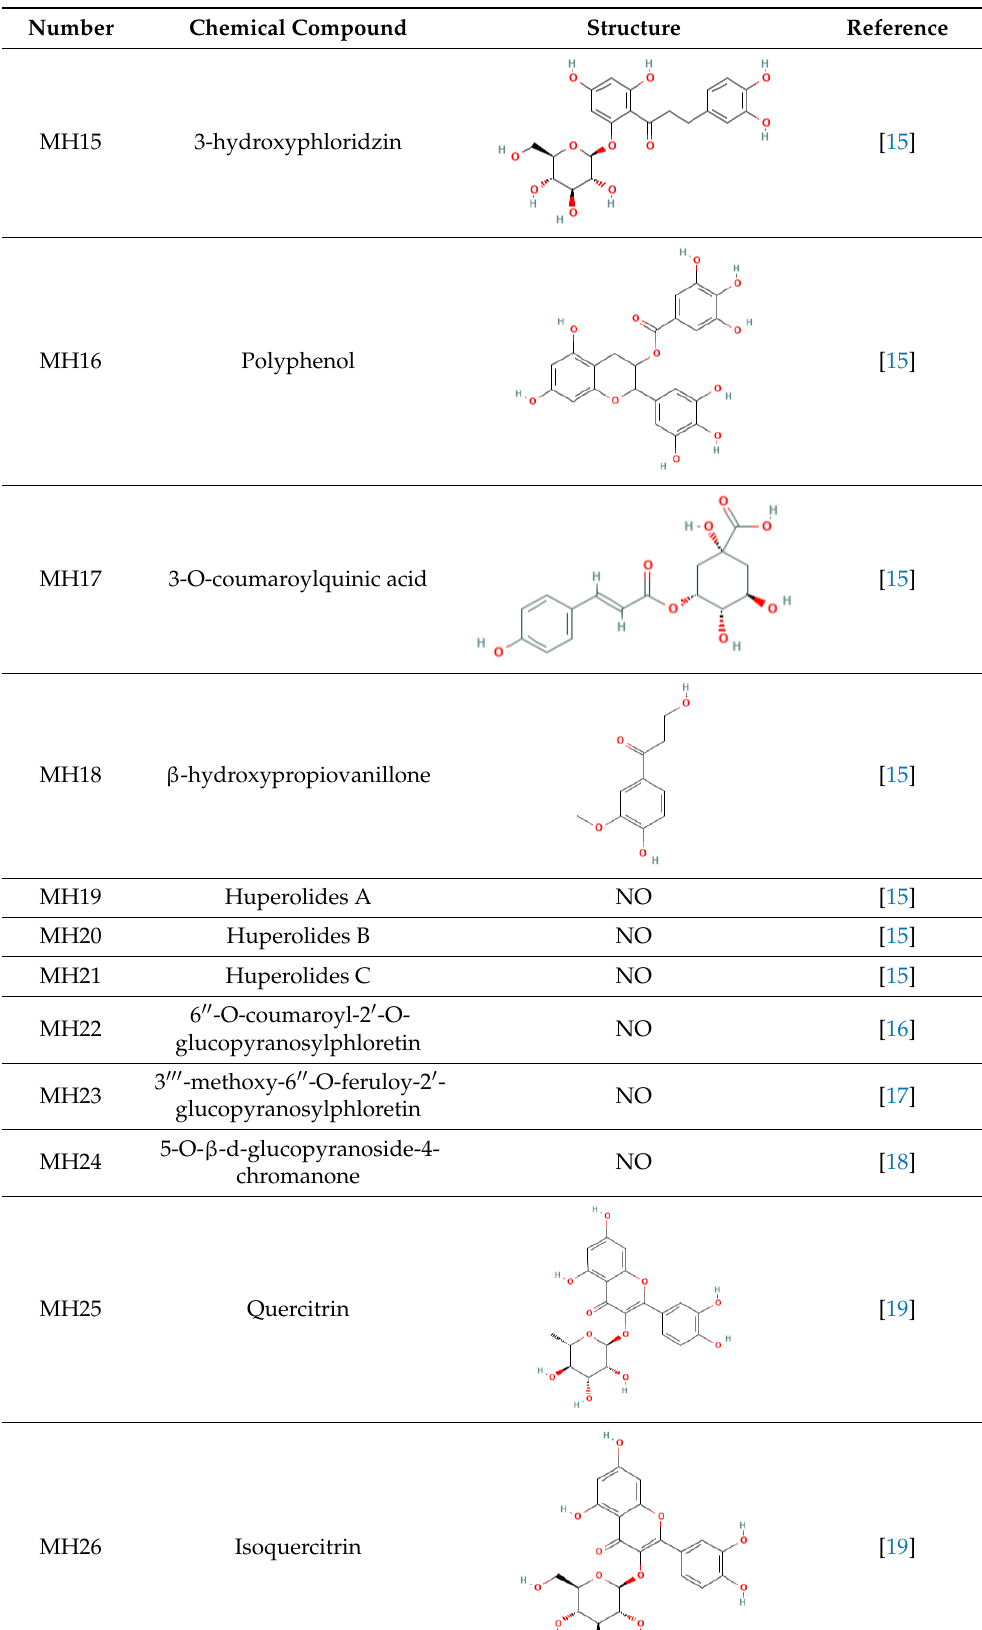
Table 1. Cont. Number